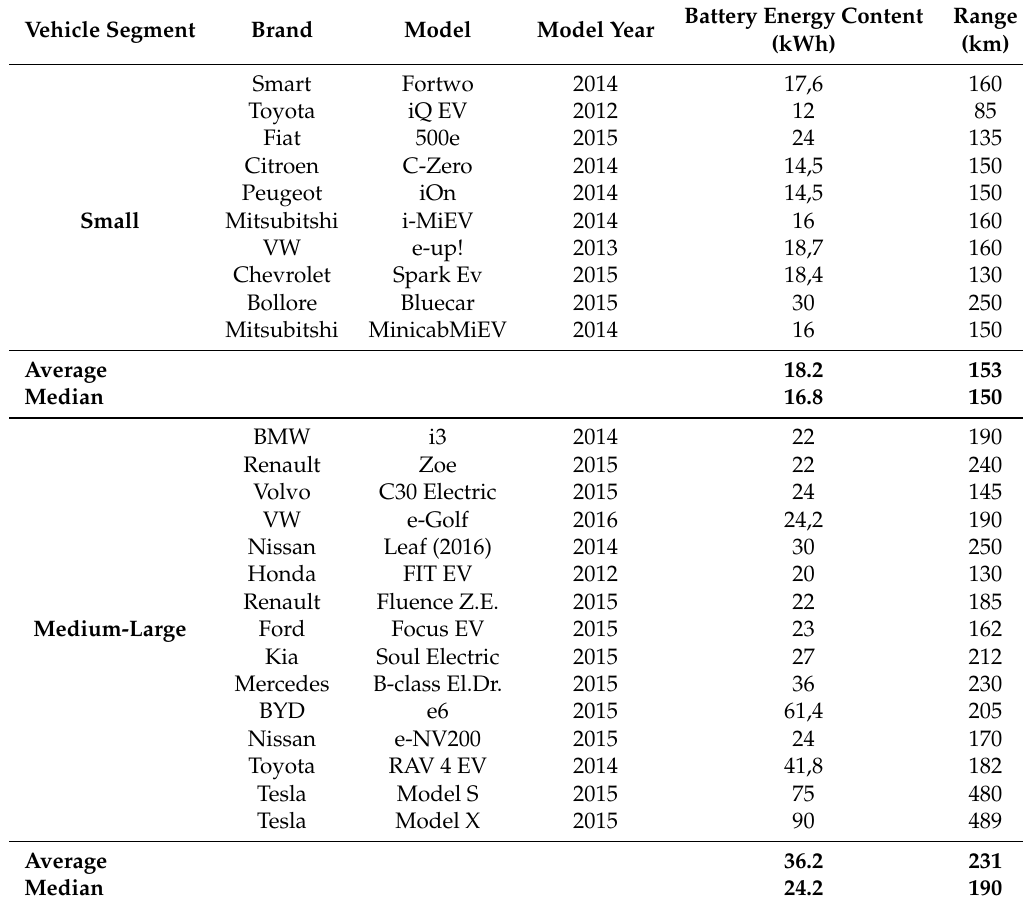
Table 1. Overview of electric vehicles commercially available in 2016, adapted from